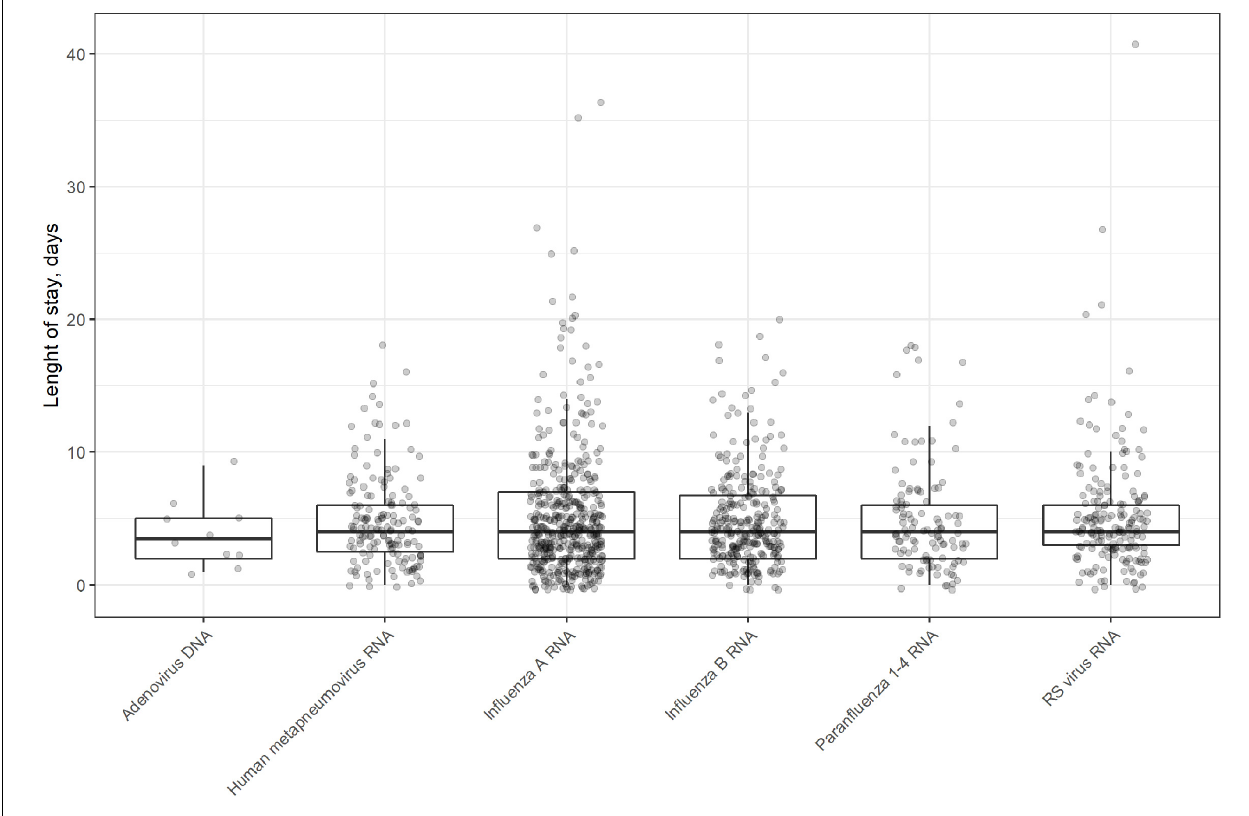
FIGURE 3 | Boxplot of length of stay in days for the different virus types in patients hospitalized with viral RTI in